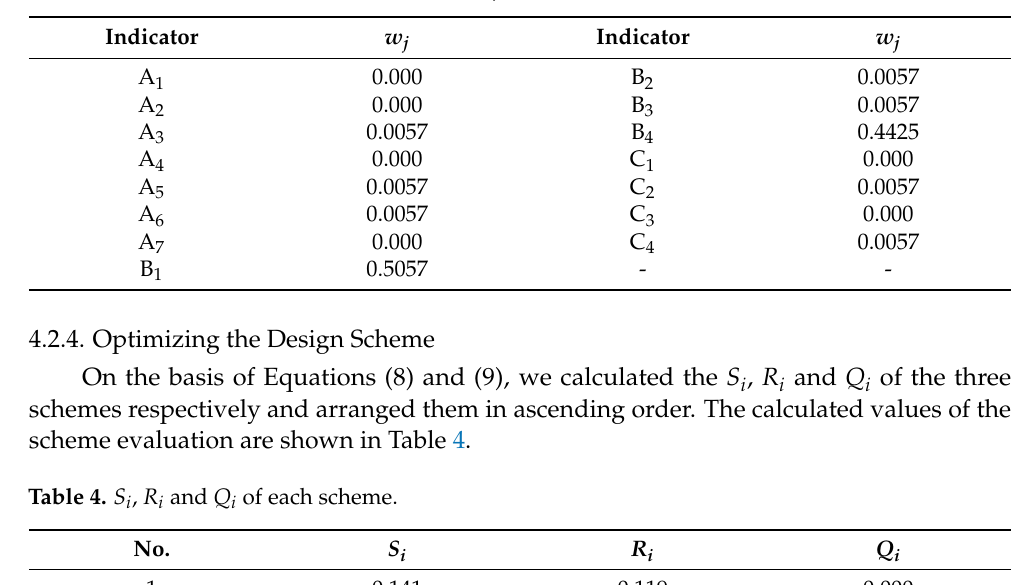
Table 3. Calculation of each indicator weight w j .